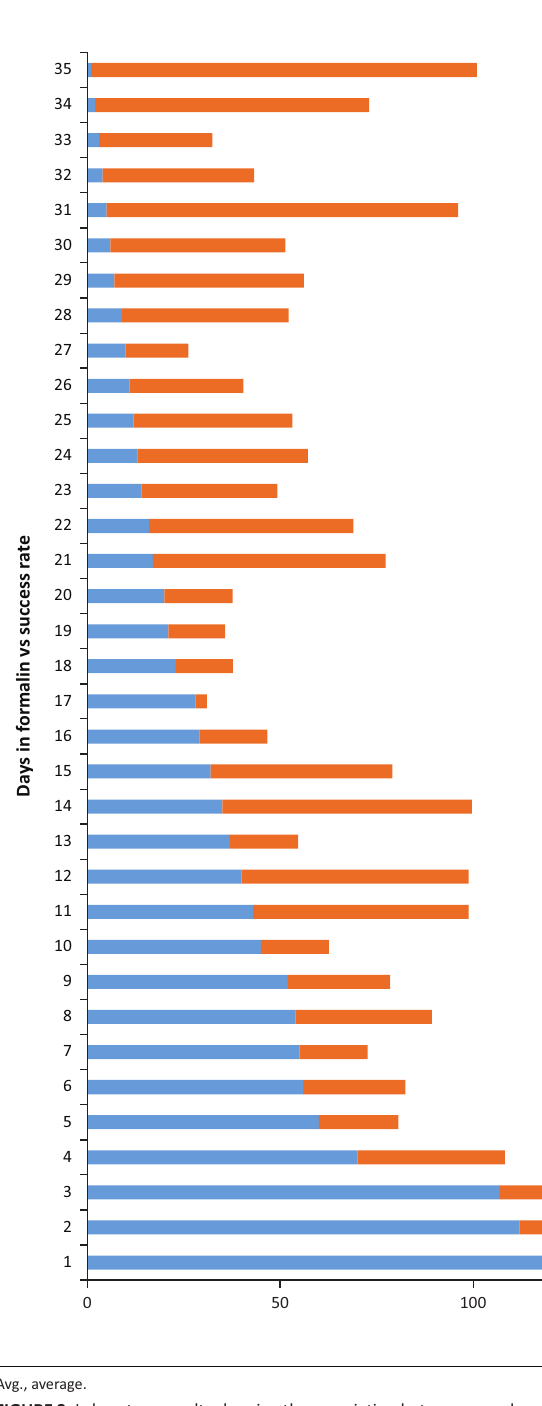
FIGURE 2: Laboratory results showing the association between a prolonged formalin fixation period and a decline in PCR amplification success rate, Pretoria, South Africa, March 2015 – July 2016 (online Supplementary Document Table